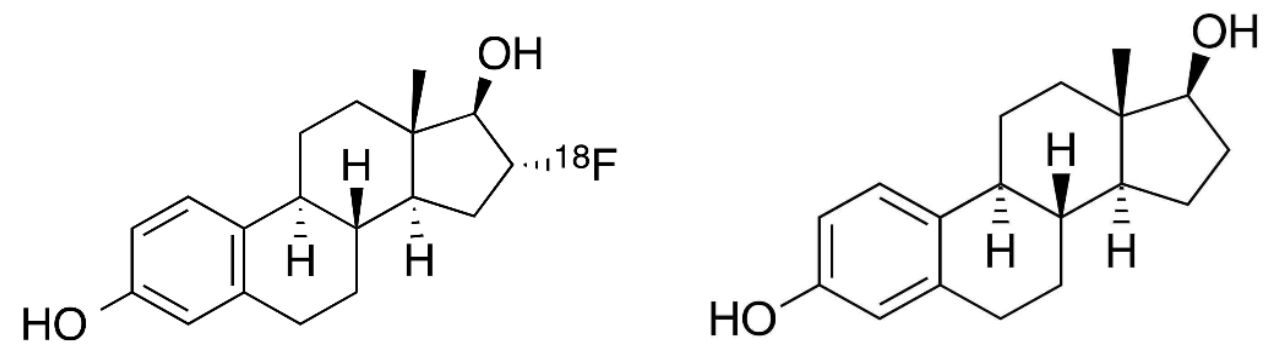
Figure 5. Comparison of chemical structures of FES (left-hand side) and of oestradiol (right-hand side).